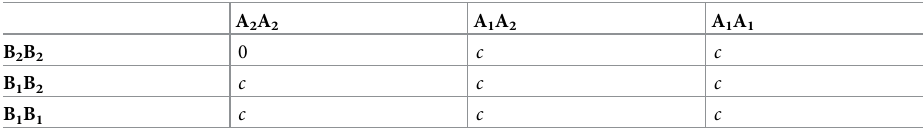
Table 2. Genotypic values of a 2-locus duplicate factor